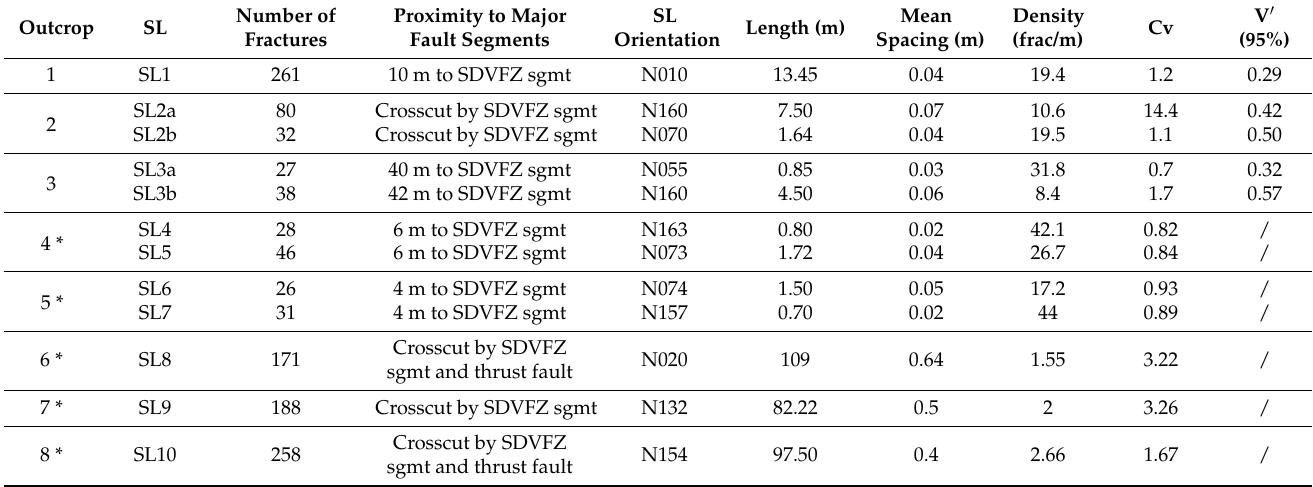
Table 1. Characteristics of the fractures acquired from each studied outcrop, along the scanlines. Outcrop 1 to 3 (without asterisk) show the characteristics of the fractures acquired directly from field scanlines. Outcrop 4 to 8 (with asterisk) show the data extracted from aligned photographs using Metashape Software v.1.6.5, with a virtual scanline. For each outcrop, number of scanlines are indicated with: Number of fractures intersected, orientation and length of scanlines, mean fractures space, density (frac/m), coefficient of variability (Cv), and V (cid:48) statistic fom [70]. The proximity to the major faults is mentioned. Mean spacing and Cv are computed with Terzaghi correction. Sgmt: